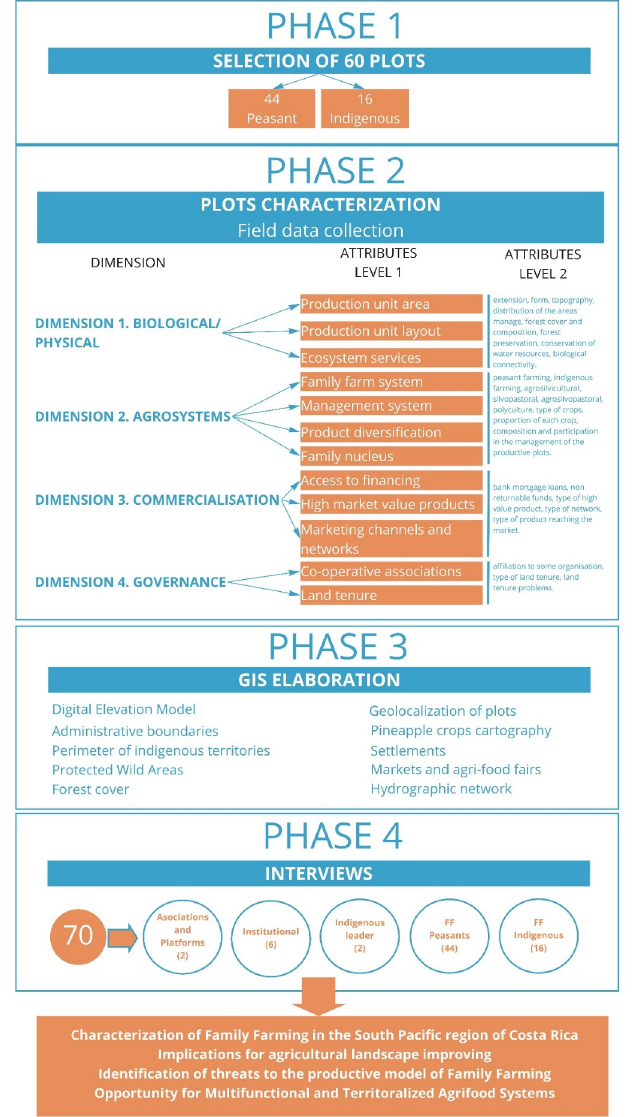
Figure 3. Scheme of research methodology. Source: generated by the authors.